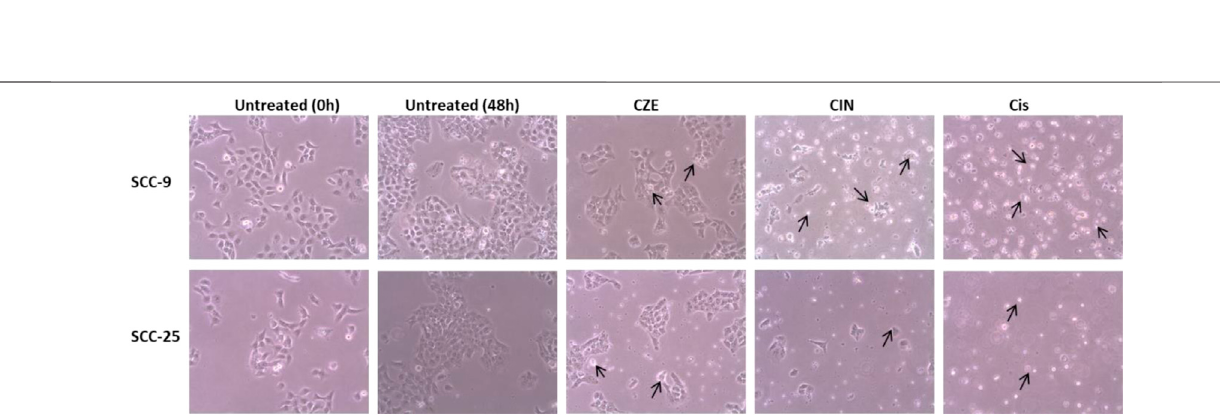
FIGURE 1 | Dose response curves showing cytotoxicity in oral cancer cells by CZE and CIN treatment. MTT assay showing dose dependent decrease in the viability of SCC-9 and SCC-25 cells after CZE (0 – 400 μ g/ml) and CIN (0 – 960 μ m) at 48 and 72 h of treatment. Each value in line graph clearly shows the signi fi cant decrease in the viability with increasing extract concentration as compared with untreated cells. The data has been represented as the mean ± SD of three independent experiments.